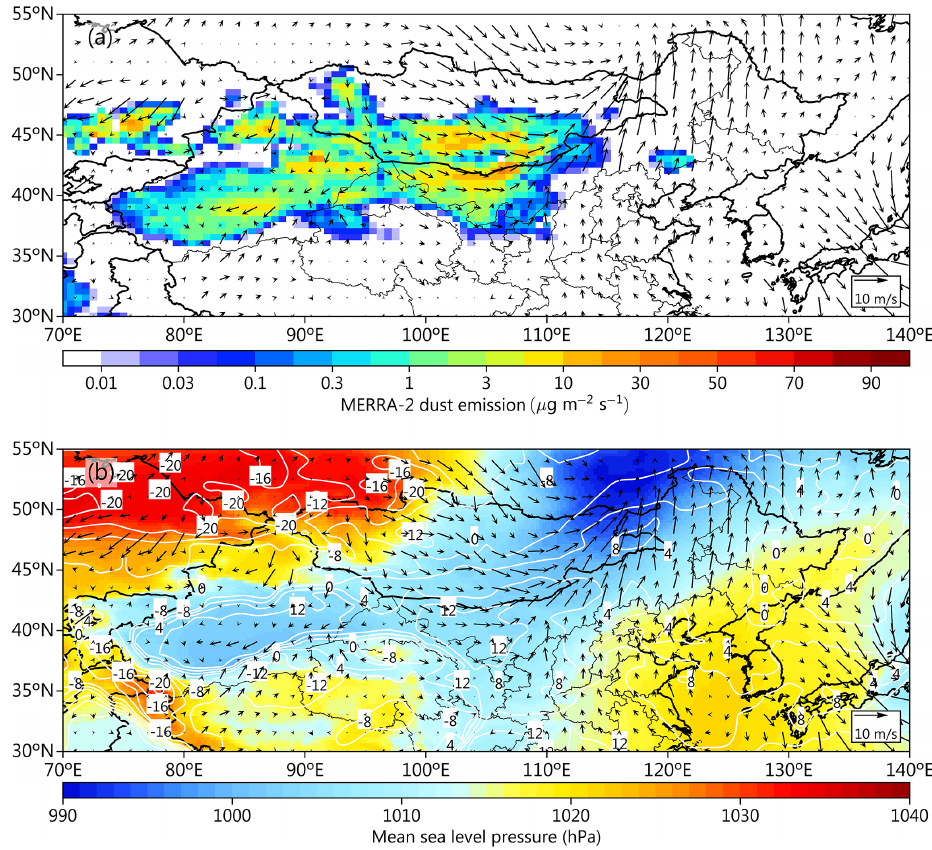
Figure 11. (a) MERRA-2 daily mean dust emissions for all size bins on 14 March 2021. (b) Daily mean sea level pressure (SLP, shading) and temperature at 2m (contour; ◦ C) on 14 March 2021. Overlaid on (a, b) are the ERA5 wind vectors at